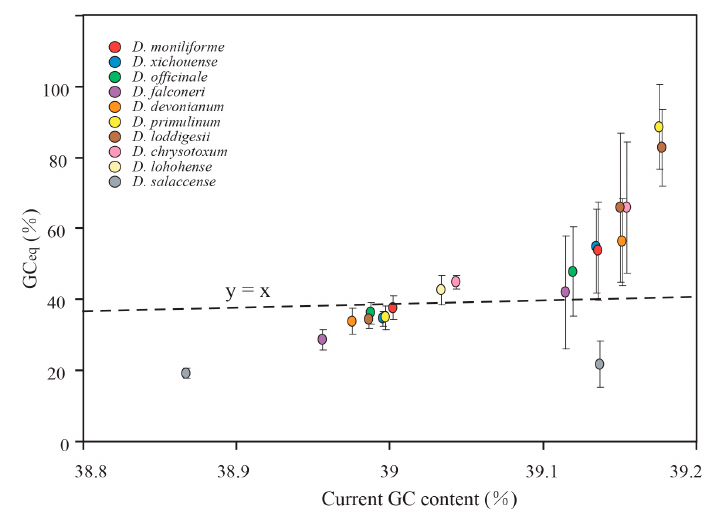
Figure 7. Comparison of GC eq values between the SC and IR regions for the protein-coding genes. Error bars depict 95% confidence intervals for GC eq . The protein-coding genes showed the same evolution trends with the non-coding loci.